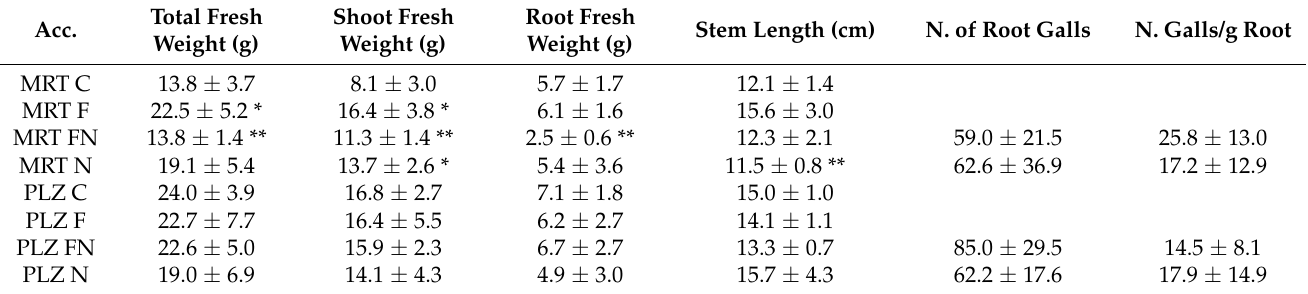
Table 1. Biometric parameters and infection data of the two tomato accessions (MRT and PLZ) tested 15 days post P. chlamydosporia inoculation (eight days after M. incognita inoculation). Treatments, N = inoculated with M. incognita MILEV-L4; FN = inoculated with P. chlamydosporia DSM 26985 and MILEV-L4; F = inoculated with DSM 26985 and C = un-inoculated, control plants. Data are the mean ± standard deviation (SD) of four biological